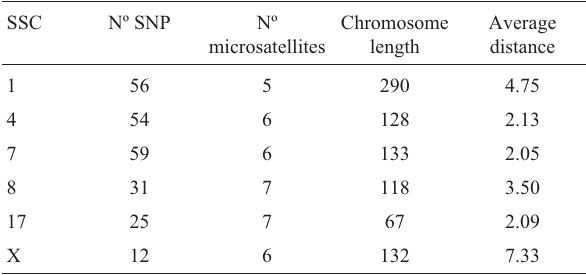
Table 1 - Number of SNP and microsatellite markers, chromosome length (cM) and average distance between markers (cM) in Sus scrofa chromo- somes 1, 4, 7, 8, 17, and